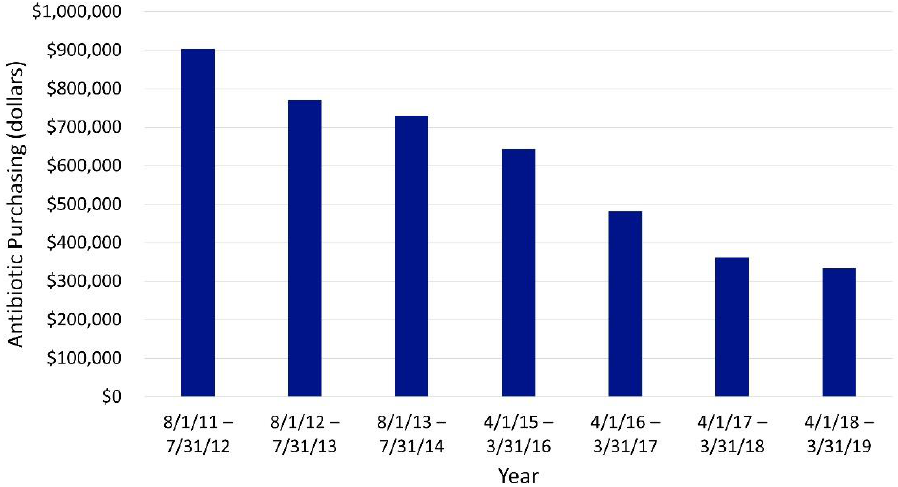
Figure 5. Yearly pharmacy antibiotic purchasing. Data are unavailable from 1 August 2014–31 March 2015 due to a change in wholesaler occurring during this time period.